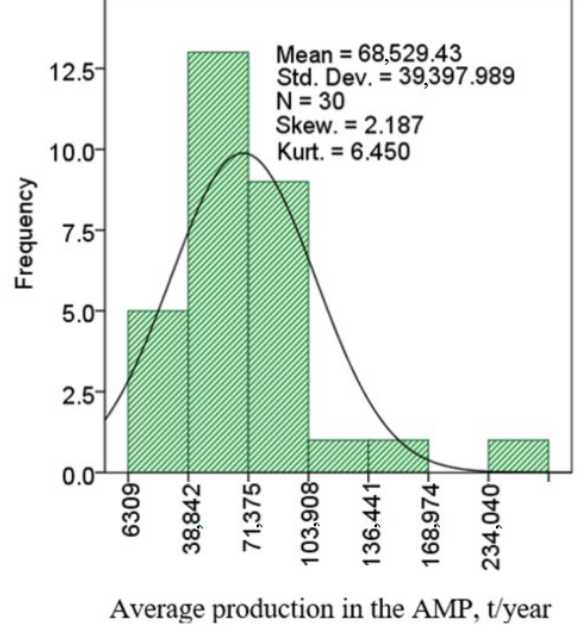
Figure 6. The variations in the average amount of HMA and WMA mixtures annually produced in a single AMP in Europe for the 12-year period (2005–2016).